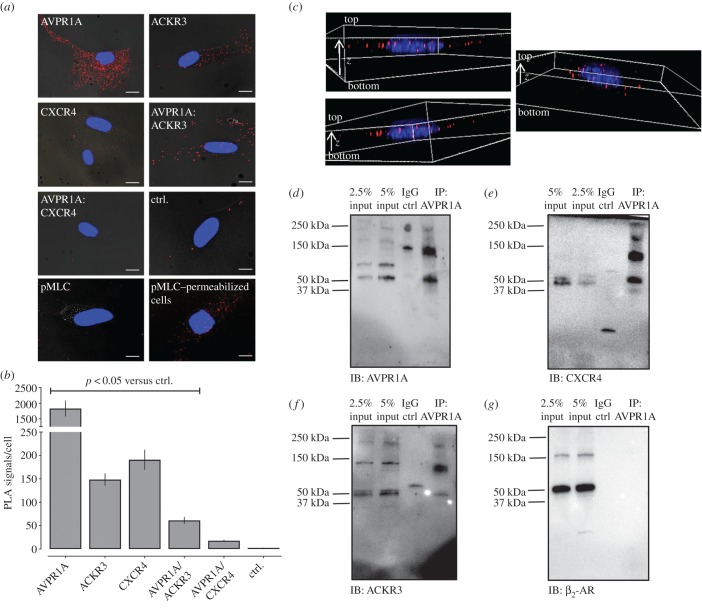
ACKR3 and AVPR1A form heteromeric complexes in hVSMCs. (a) Representative PLA images for the detection of individual receptors, receptor–receptor complexes and pMLC2 in hVSMC. PLA for pMLC2 was performed in non-permeabilized cells (pMLC2, bottom left) and permeabilized cells (pMLC2, permeabilized cells, bottom right). All other PLAs were performed in non-permeabilized cells. Ctrl: omission of one primary antibody. Images show merged PLA/DAPI signals acquired from z-stack images (n = 10; thickness 1 µm, bottom to top). Scale bars, 10 µm. (b) Quantification of PLA signals per cell as in (a). n = 4 independent experiments with n = 10 images per condition and experiment. (c) Three-dimensional representations of ACKR3 : AVPR1A interactions in hVSMC. Deconvolved images were generated from z-stack images (n = 20; thickness: 0.5 µm, bottom to top). Images show merged PLA/DAPI signals. (d–g) hVSMCs were lysed (=input) and AVPR1A was immunoprecipitated (IP) followed by immunoblotting (IB) to detect AVPR1A (d), CXCR4 (e), ACKR3 (f) and β2-AR (g) in the IP samples. IP control: precipitate after incubation of cell lysates with IgG-coupled resin. Images are representative of n = 4 independent experiments.